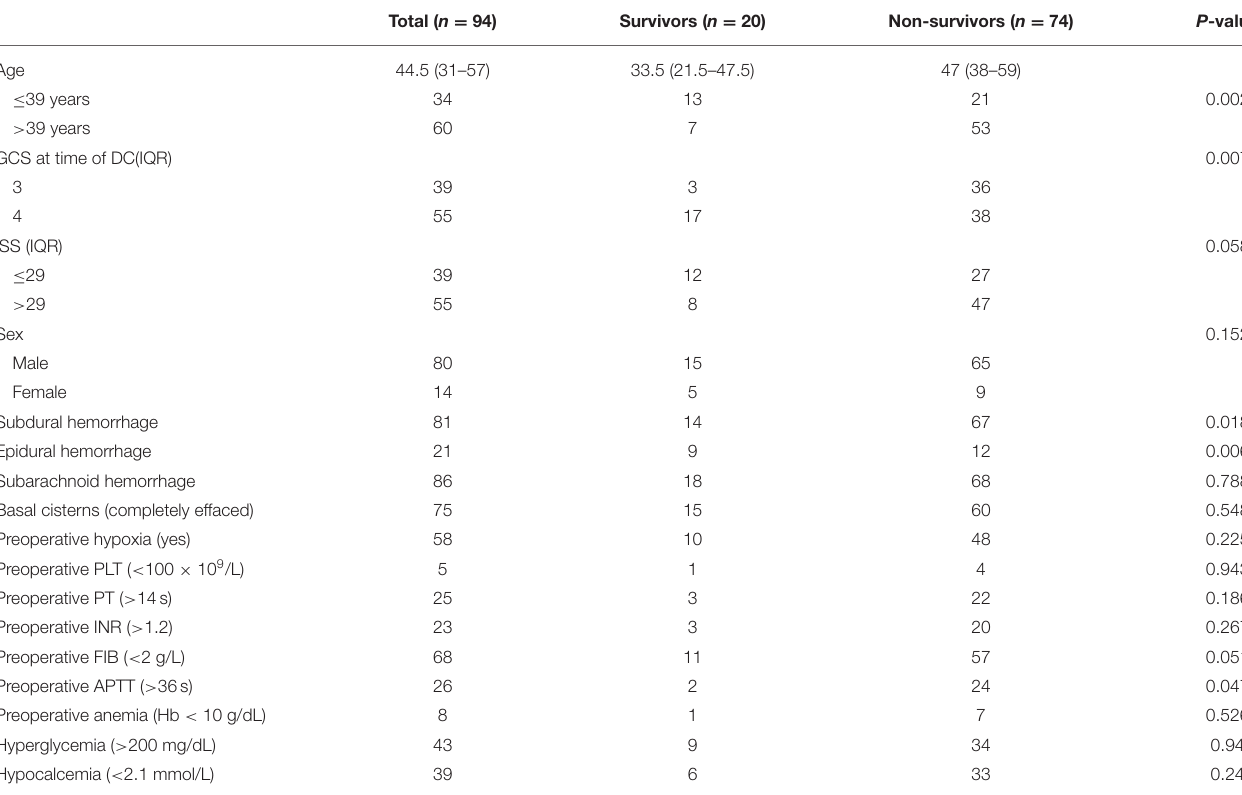
TABLE 1 | Comparison between survivors and non-survivors with Glasgow Coma Scale < 5 and bilateral dilated pupils undergoing decompressive craniectomy.